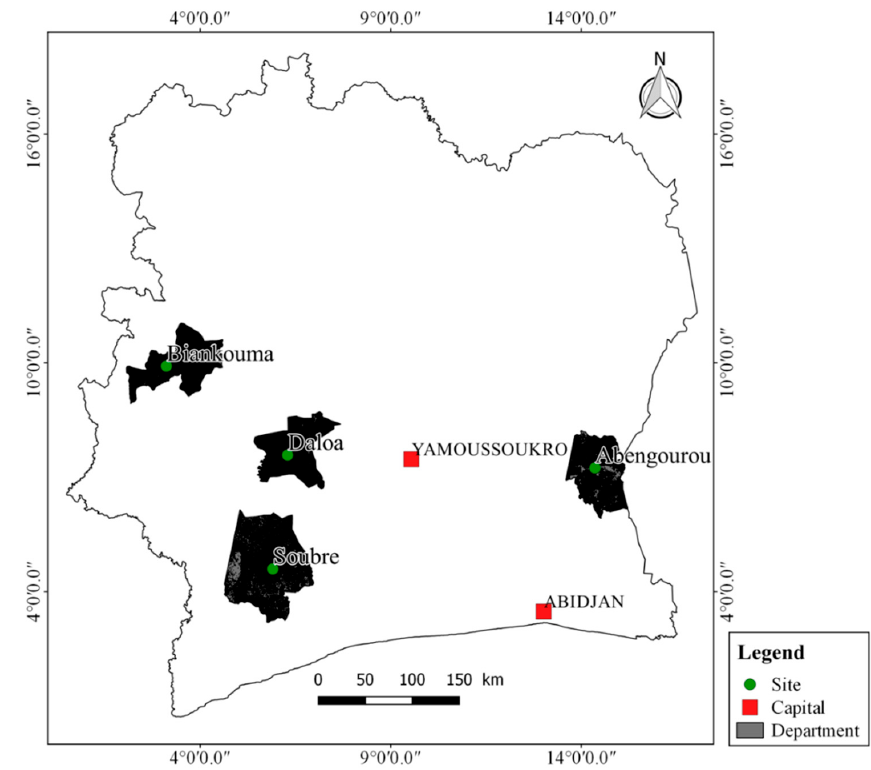
Figure 1. Presentation of study area.